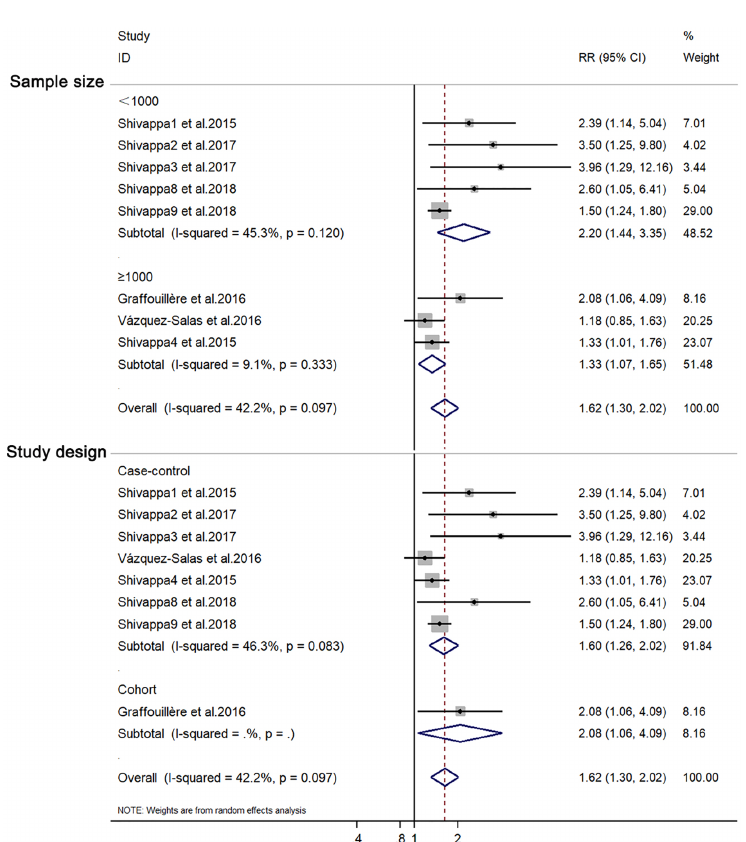
Fig 2. Forest plots showing RR with 95% CI of urologic cancer comparing the highest to the lowest dietary inflammatory index score.